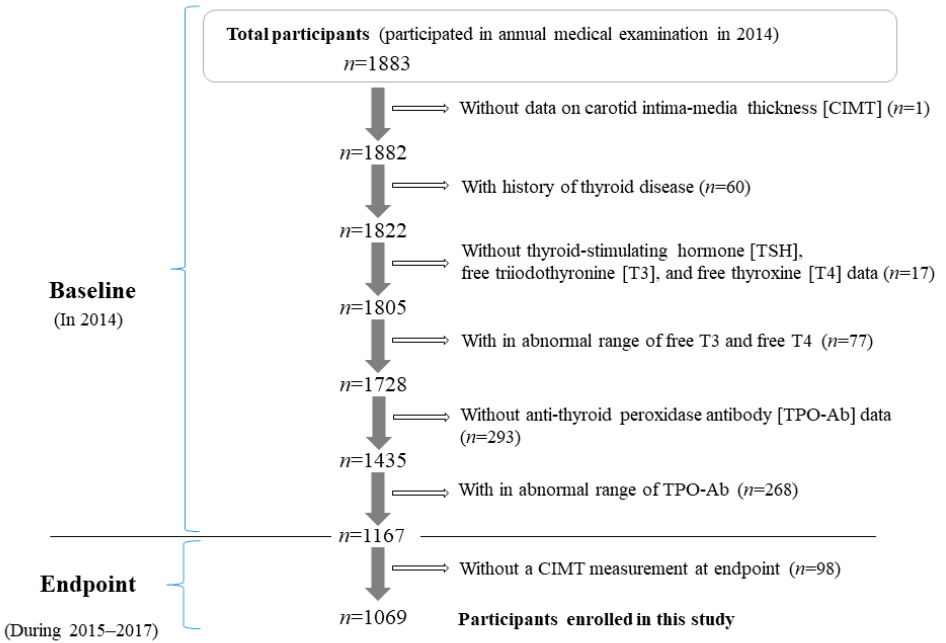
Figure 1. Demographics of study population.